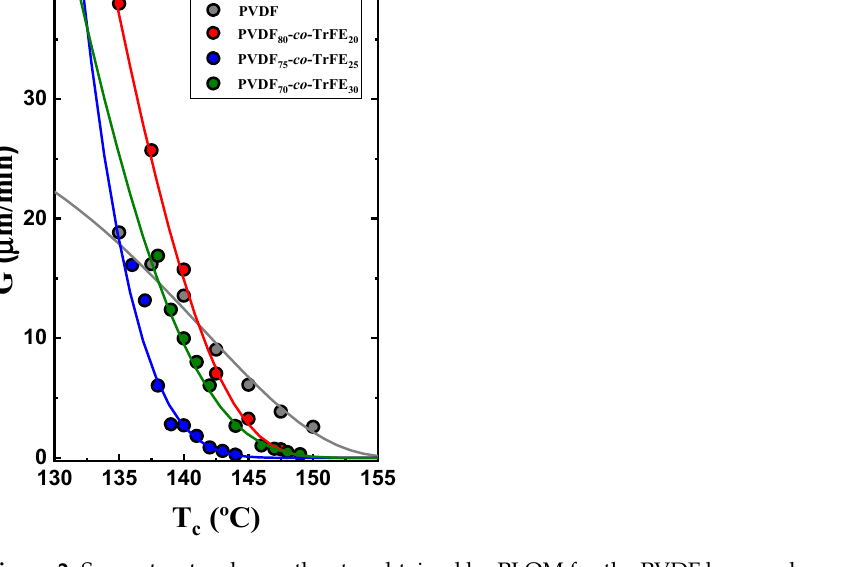
Figure 2. Superstructural growth rates obtained by PLOM for the PVDF homopolymer and P(VDF- co -TrFE) random copolymers at different compositions against the crystallization temperature.